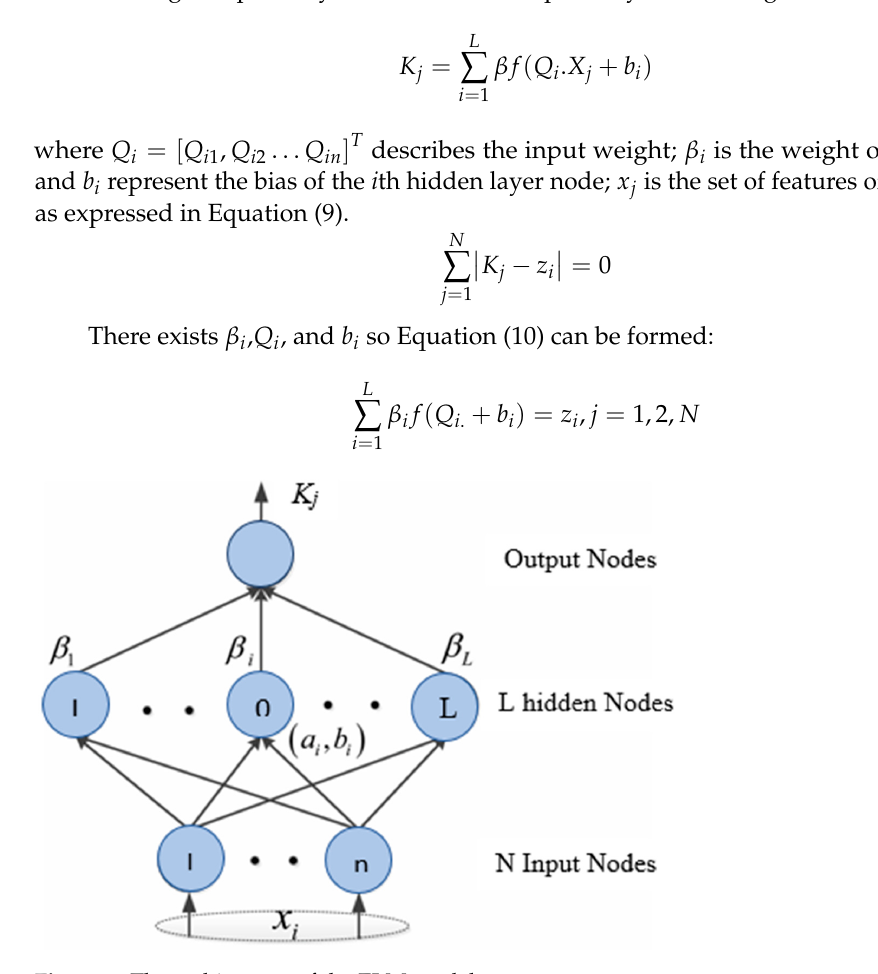
Figure 5. The architecture of the ELM model.